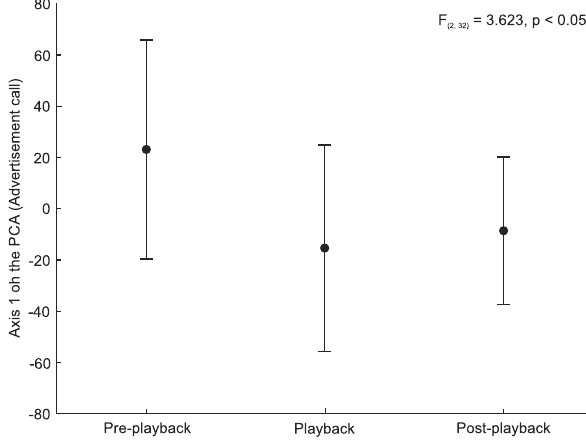
Figure 4. Results of the two-way repeated measures of analysis of variance (ANOVA) computed for axis 1 of the PCA performed to advertisement call of H. goianus males. * Tukey’s test (p <